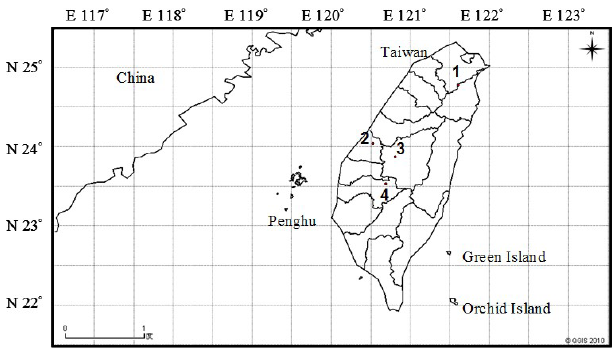
Fig 1. Collecting sites of Strumigenys ants. 1: Fushan, Ilan County; 2: Pakuashan, Changhua City; 3: Chichi, Nantou County; 4: Shuisheliao, Chiai County.